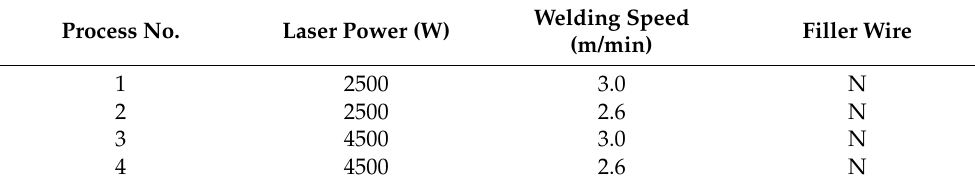
Figure 1. Welding schematic diagram and welding equipment: ( a ) the schematic diagram of the laser welding plate butt joint; ( b ) the schematic diagram of laser deep penetration welding. Table 2. Welding process parameters.